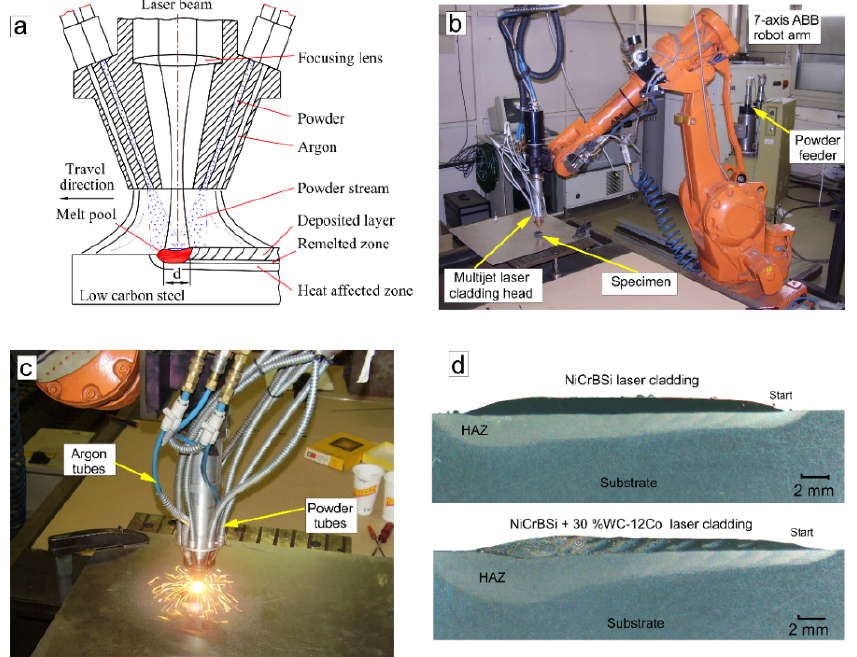
Figure 2. ( a ) Schematic of coaxial laser cladding head cross-section: ( b ) laser cladding system, ( c ) during laser cladding and ( d ) cross-section of the macrostructures. Table 3. Solid-state Nd:YAG laser cladding parameters.